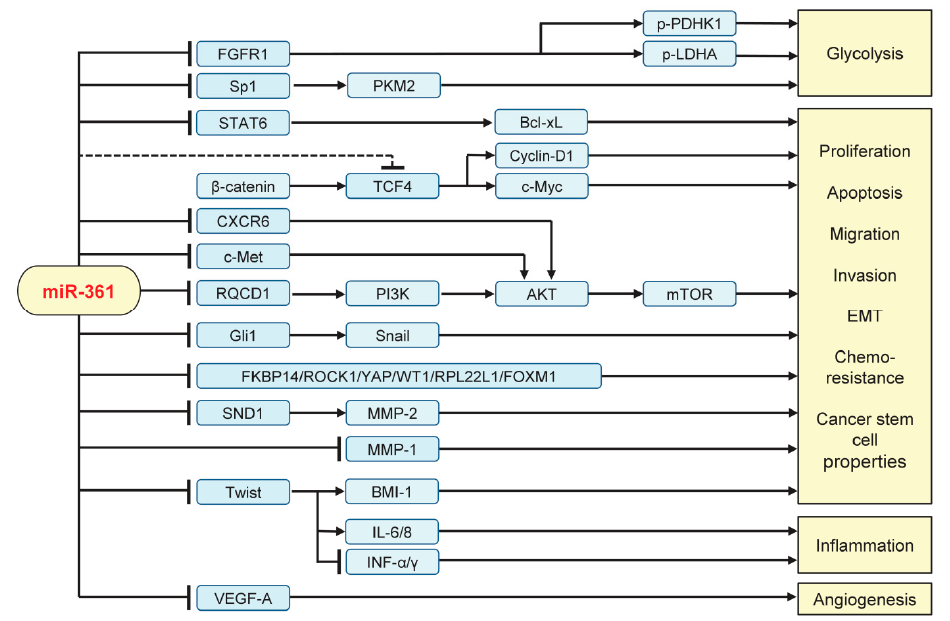
Figure 3. Validated targets and signaling pathways regulated by miR-361 in human tumor cells. FGFR1: Fibroblast growth factor receptor 1; Sp1: Transcription factor; STAT6: Signal transducer and activator of transcription 6; PKM2: pyruvate kinase M2; PDHK1: pyruvate dehydrogenase kinase 1; LDHA: